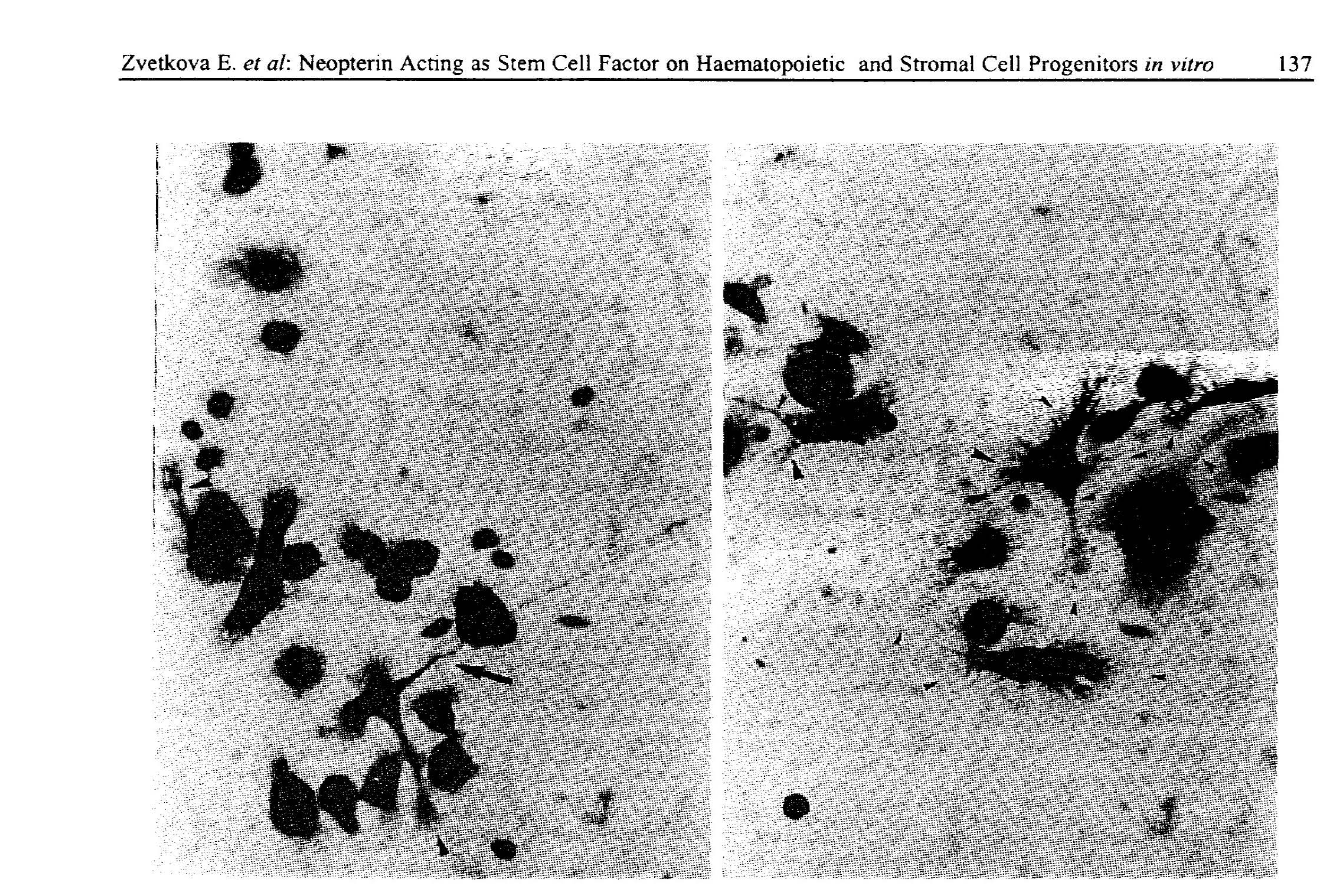
Figure 3. Granulocyte/macrophageal cluster with dendritic cells forming very long cytoplasmic dendrite-like pro trusions (arrow) in mouse bone marrow agar culture (at day 7 of cultivation) - exogenously treated by neopterin. Staining by the method of Zvetkova and Jelinek; x 1250, Immersion (13) clusters of undifferentiated lymphocyte-like